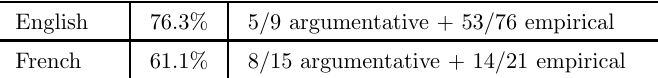
Presence of a Background